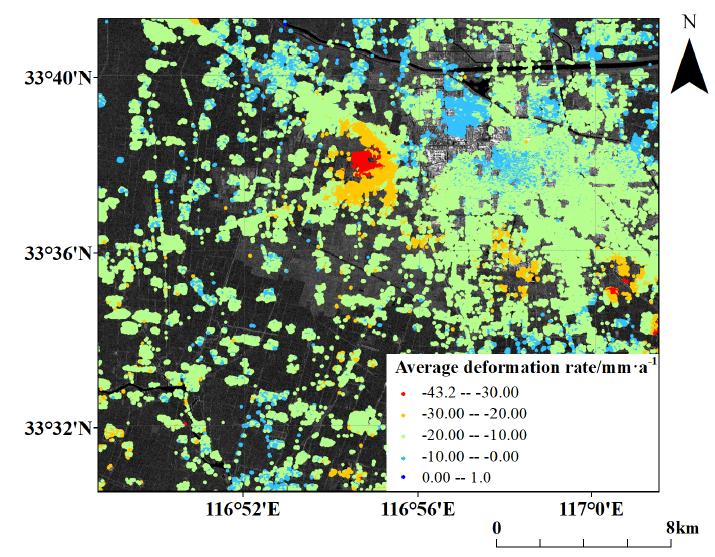
Figure 16. Data integration result of those two